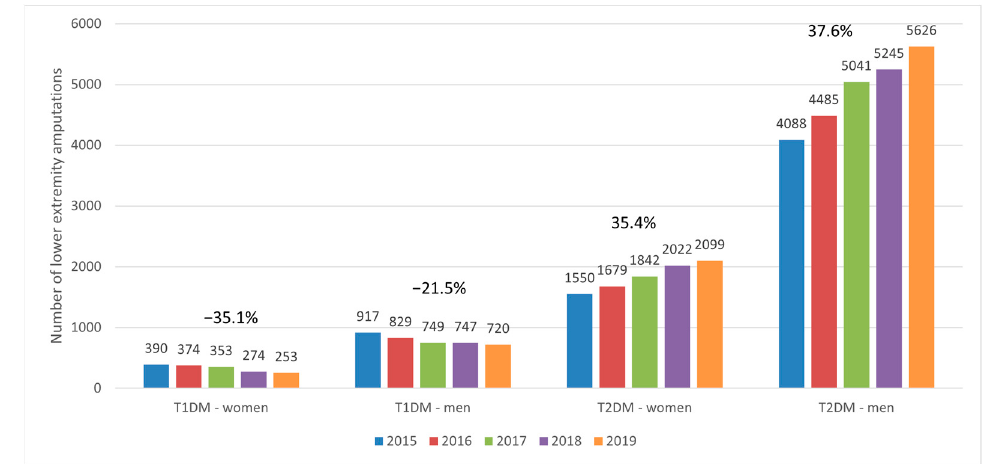
Figure 3. Trends in the number of lower extremity amputations in patients with T1DM and T2DM, according to sex. T1DM, type 1 diabetes mellitus; T2DM, type 2 diabetes mellitus. Overall, women had a lower number of amputations than men; while women with T1DM had a share of major amputations that was largely similar to that seen in men, in women with T2DM, the share of major amputations was up to 10% higher compared with men (Table 2). The risk of major amputations was also higher in women with T2DM compared with men, for all study years: 1.37 in 2015, 1.33 in 2016, 1.21 in 2017, 1.27 in 2018 and 1.23 in 2019. The ratio of minor-to-major amputations was lower in women with T1DM than in men: 2.12 vs. 3.00 in 2015, 2.56 vs. 2.67 in 2016, 2.53 vs. 3.01 in 2017, 3.22 vs. 3.45 in 2018 and 2.83 vs. 3.56 in 2019. The same was true for women and men with T2DM: 1.62 vs. 2.59 in 2015, 1.78 vs. 2.69 in 2016, 2.02 vs. 2.65 in 2017, 1.86 vs. 2.63 in 2018 and 2.08 vs. 2.80 in 2019. Table 2. Absolute number, crude incidence and level of amputations according to year, type of di- abetes and sex.